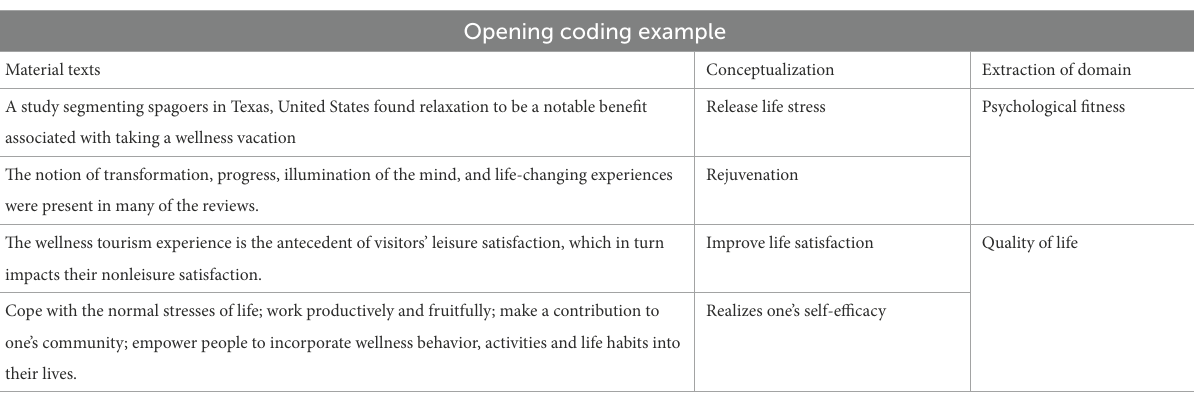
TABLE 1 Opening coding